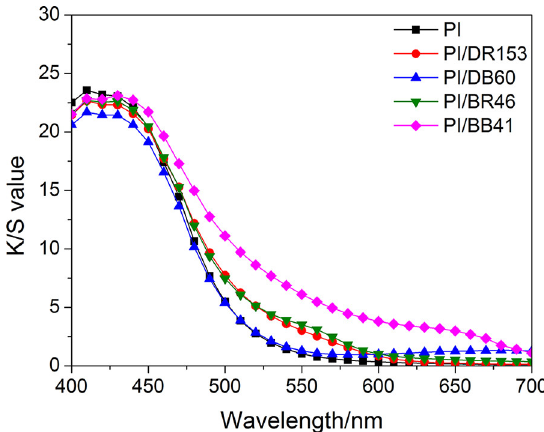
Figure 5. Effect of disperse dyes and basic dyes on the color strengths of PI fibers.